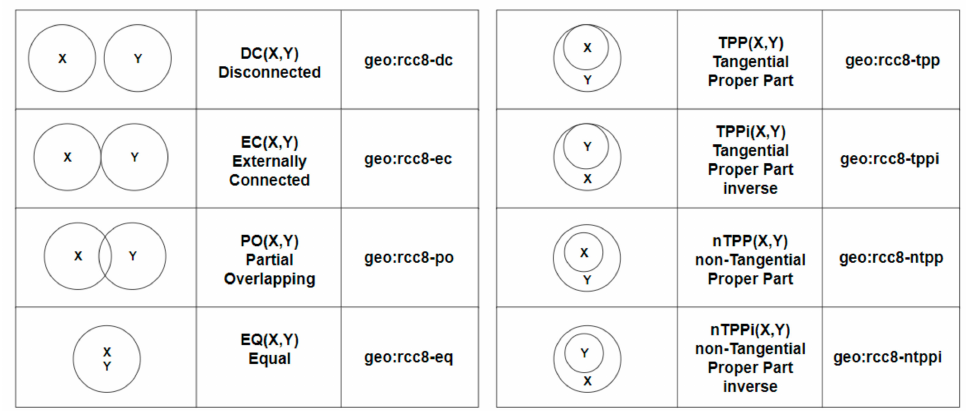
Figure 6. Region Connection Calculus 8 with corresponding GeoSPARQL topological vocabularies.